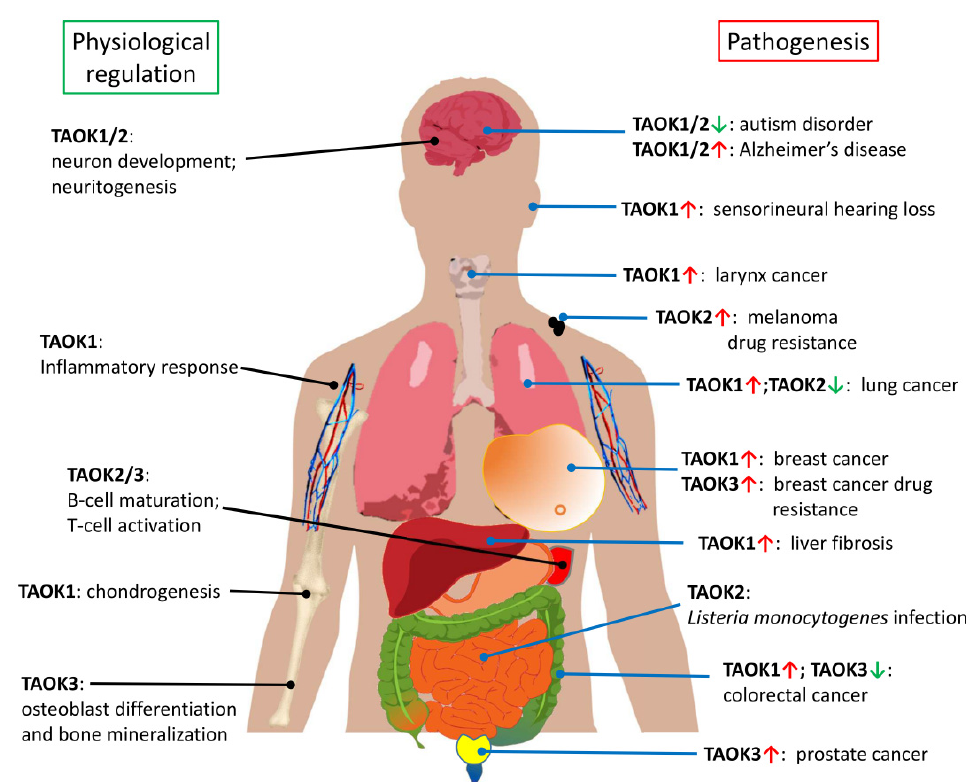
Figure 4. Current knowledge of TAOKs in physiological regulation and pathogenesis. The red “UP” arrows indicate increased expression of TAOK; the green “DOWN” arrows indicate decreased expression of TAOK. This figure contains elements (liver, stomach, and intestine) downloaded from the public domain (see “Acknowledgements” for details).